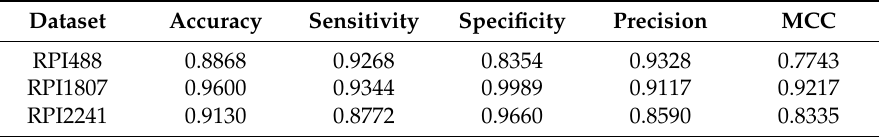
Table 1. Prediction Performance on Dataset RPI488, RPI1807, and RPI2241.